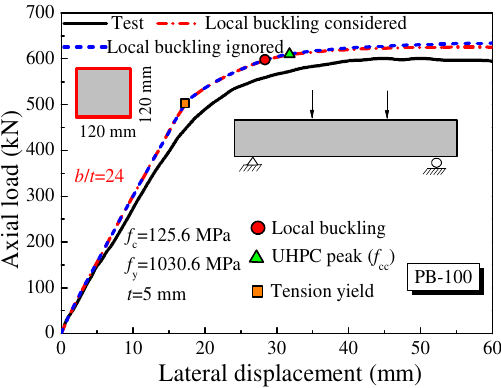
Figure 9. The comparisons of predicted F-Δ curves with test results (Huang et al. [36]).